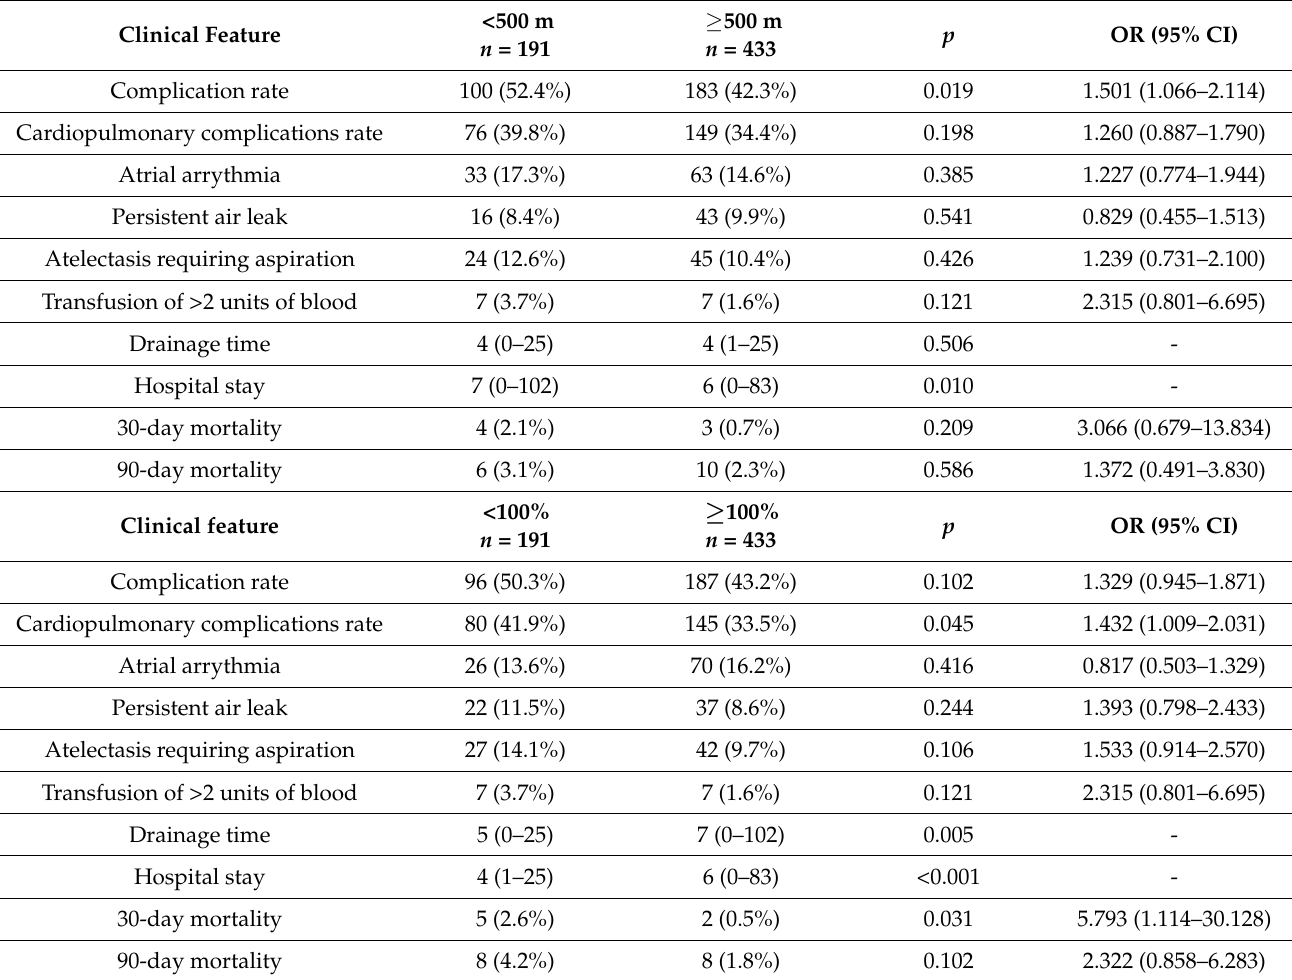
Table 3. Postoperative complications. Patients are divided into two groups depending on the 6MWD and %6MWD. The cut-off values are 500 m and 100%,